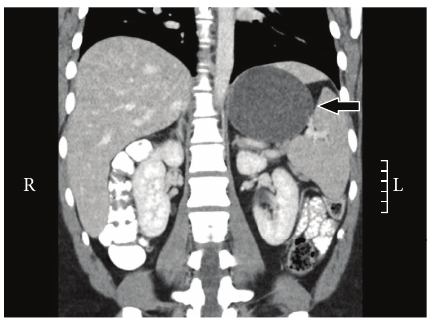
Figure 2: Computed tomography of intra-abdominal cysts. Arrow points to bronchogenic cyst arising from the stomach wall (coronal).